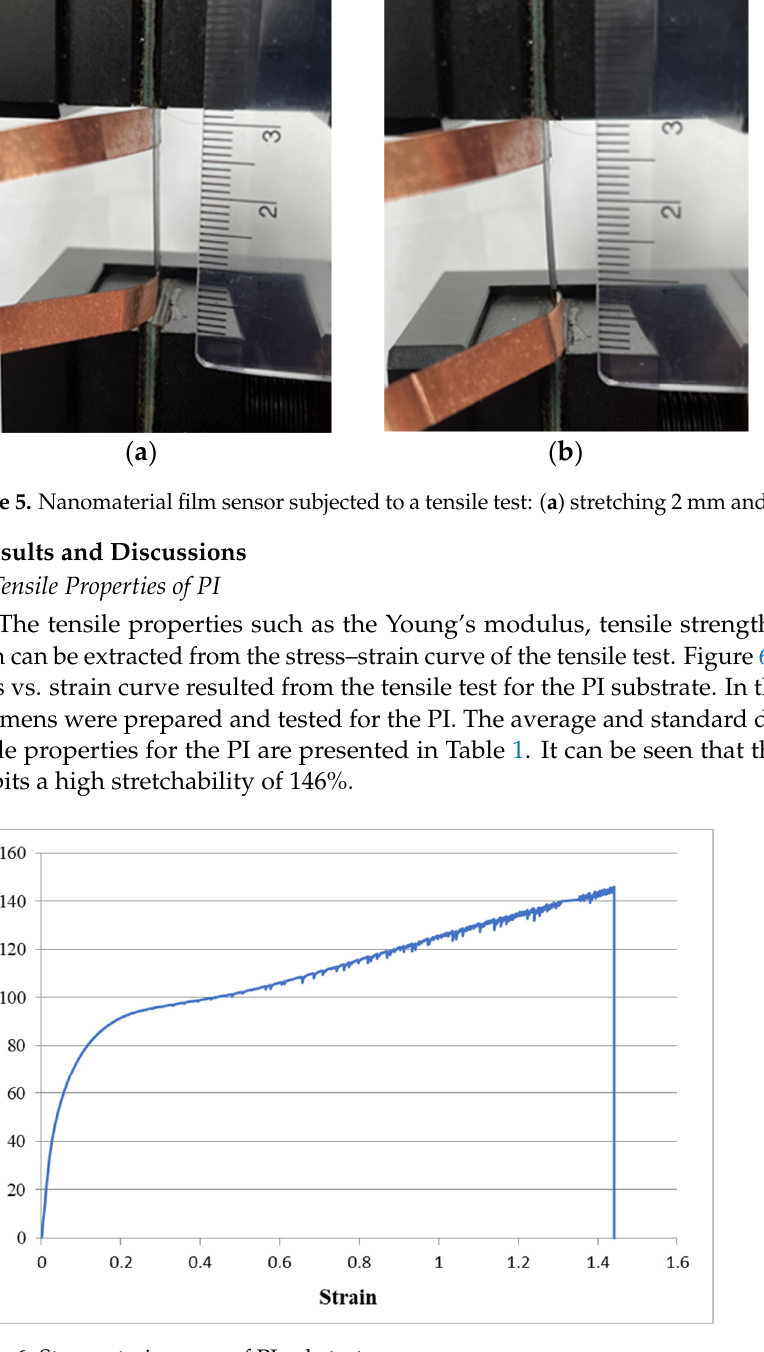
Figure 6. Stress–strain curve of PI substrate. Table 1. Tensile properties of the PI